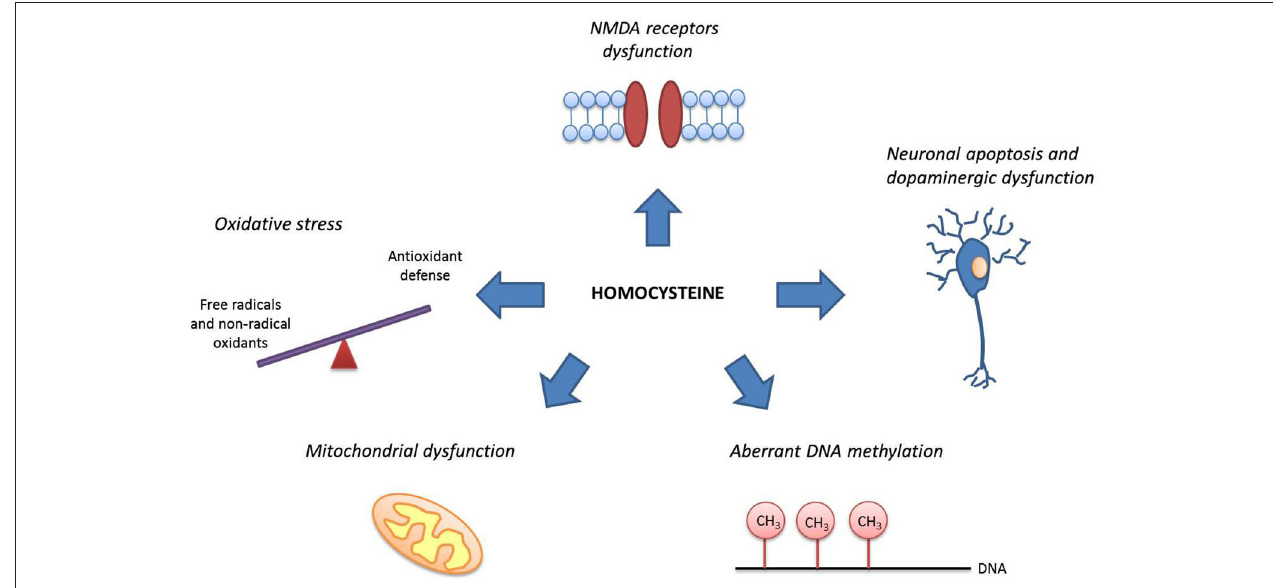
dopaminergic neurons, initiate neuronal apoptosis, induce oxidative stress, lead to mitochondrial dysfunction and influence DNA methylation altering gene